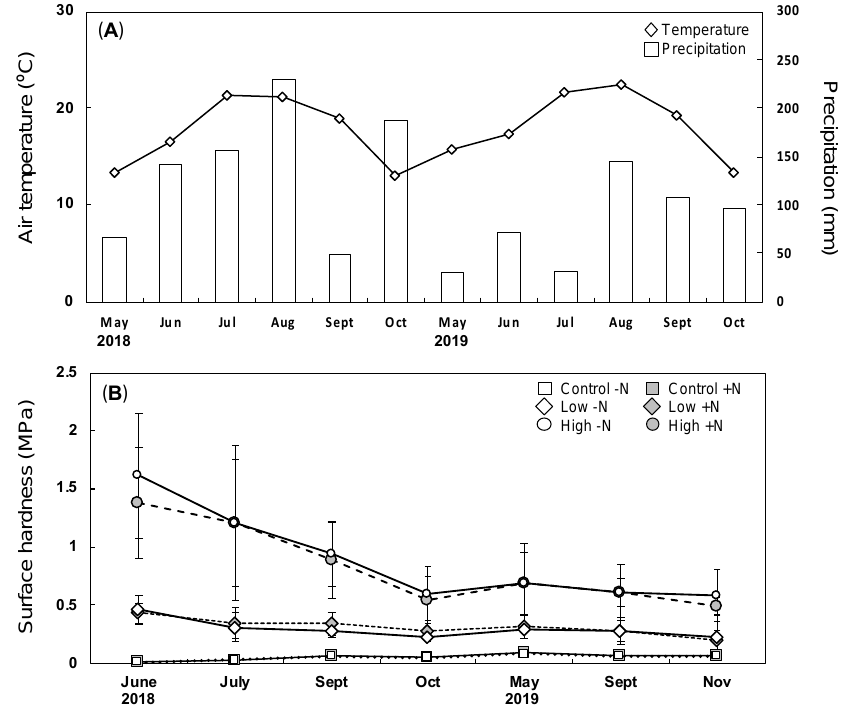
Figure 1. Meteorological and soil conditions at the study area. ( A ) The meteorological conditions in each month; Diamond: mean air temperature; Bar: total precipitation. ( B ) The seasonal changes in average surface SH ± standard error (SE); square: control; diamond: low compaction level; circle: high compaction level; white: non-N loading (−N); gray: N loading (+N). ( n = 5).